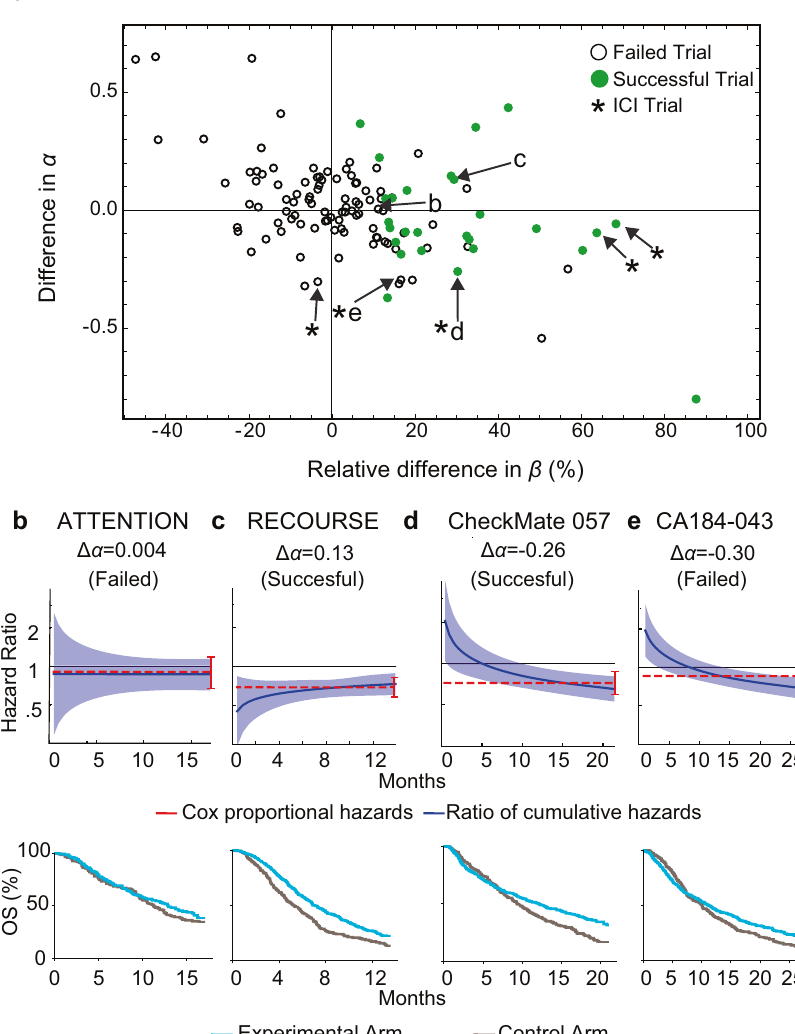
Fig. 6 Parameter values for Weibull fi ts to overall survival (OS) data scored by trial outcome. a Differences in Weibull α and β parameters for experimental and control arm OS data (121 comparisons from 116 trial fi gures). For α , the value for the control arm was subtracted from the value for the experimental arm. Differences in β were computed by determining the percent change in β in the experimental arm with respect to the control arm (positive values indicate larger β in the experimental arm). Asterisks denote trials that tested immune checkpoint inhibitors (ICIs). Success in all cases was judged based on the original report and most often corresponded to a hazard ratio less than one at 95% con fi dence based on Cox proportional hazards regression. Published hazard ratios and associated con fi dence intervals (red lines) and mean Weibull ratios of cumulative hazards (blue lines) with corresponding 95% con fi dence intervals, along with the reconstructed survival curves, of four clinical trials in the data set: b NCT01377376 (tivantinib plus erlotinib vs. erlotinib), c NCT01607957 (TAS-102 vs. placebo), d NCT01673867 (nivolumab vs. docetaxel), e NCT00861614 (ipilimumab vs. placebo after